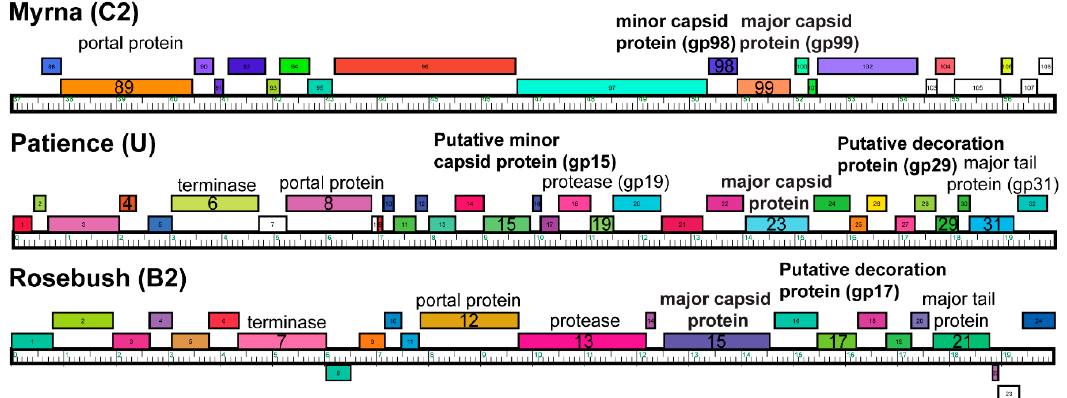
Figure 6. Gene organization of structure proteins. A portion of each bacteriophage genome displayed with the phamerator software [42] showing the positions of the annotated structural proteins.